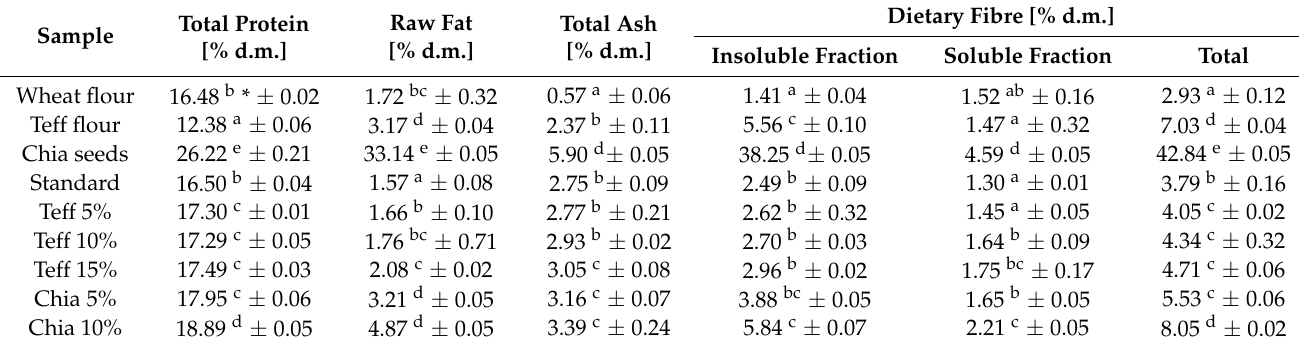
* Table shows mean values ± standard deviations and standard error of mean; a, b, c, d –mean values in columns denoted by different letters differ statistically significantly ( p ≤ 0.05). The results of the nutrient content of wheat flour and enrichment raw materials (teff flour and chia seeds) and the tested breads are presented in Tables 5–7. Table 5. The content of selected chemical components in the tested flours and bread.